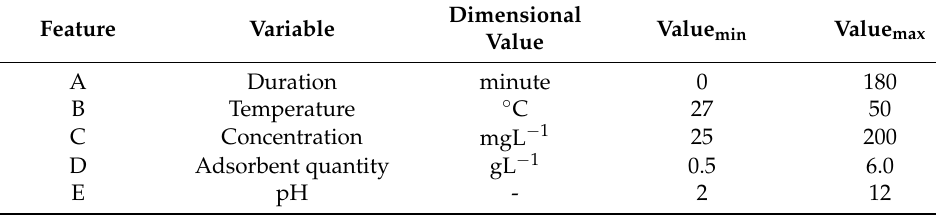
Table 1. Test range for singular components [27] (adapted with permission from the